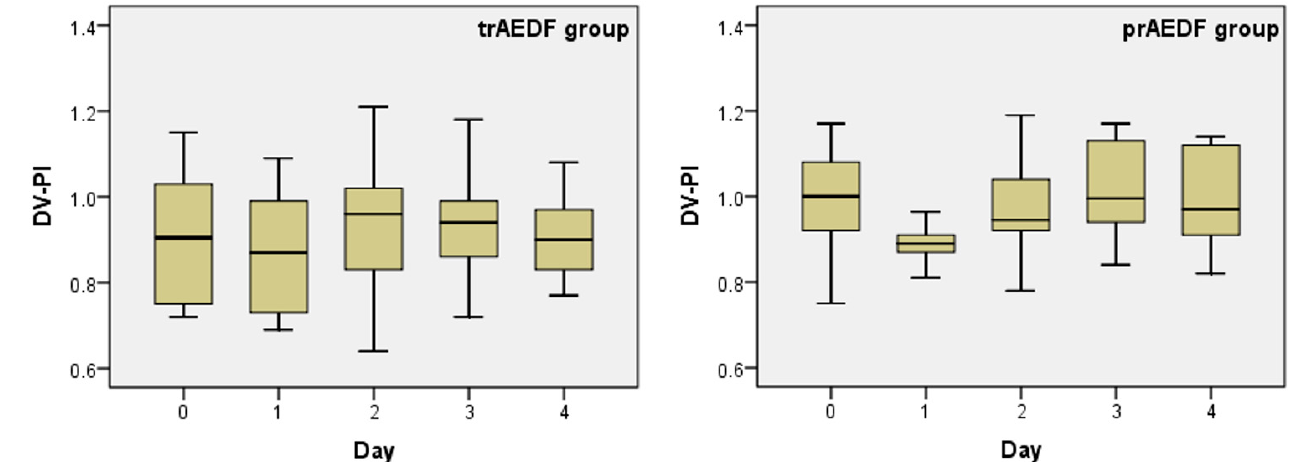
Figure 4. Boxplot charts on the pulsatility index in the ductus venosus (DV-PI), prior (day 0) and in the first 4 days after maternal dexamethasone administration, in the two groups (tr/prAEDF = transiently restored/persistent absent end-diastolic flow in umbilical artery group).